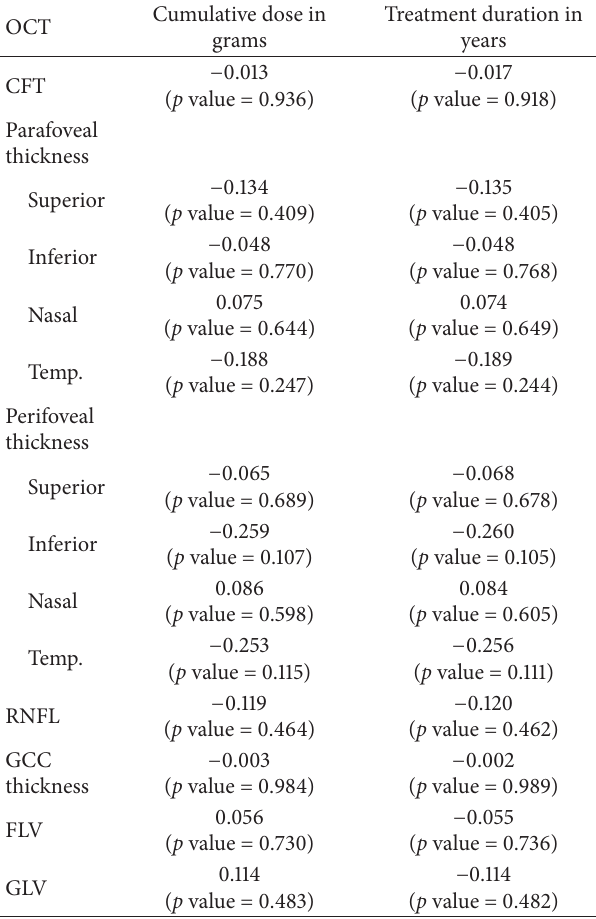
Table 3: Pearson’s correlation coefficient ( 𝑟 ) between thecumulative dose and treatment duration and the OCT parameters in the study